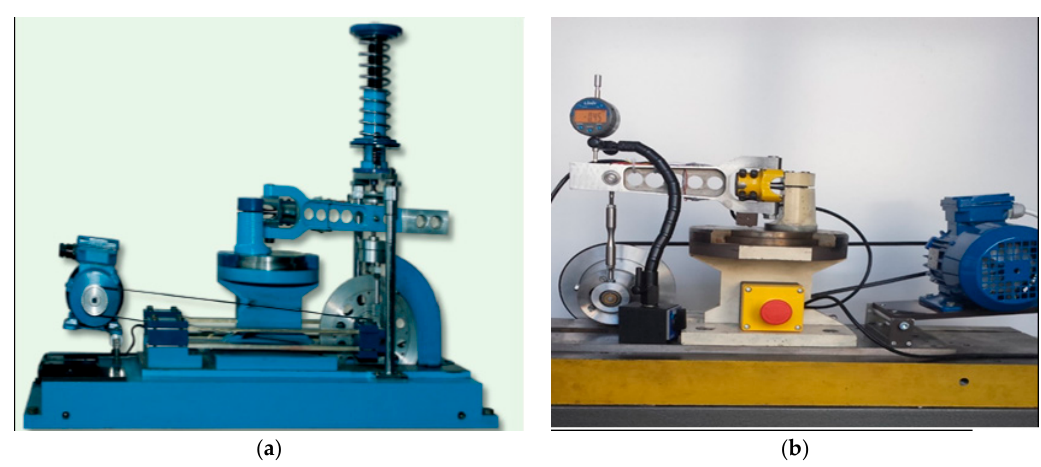
Figure 5. Research stands for fatigue tests with ( a ) controlled moment and ( b ) controlled strain.